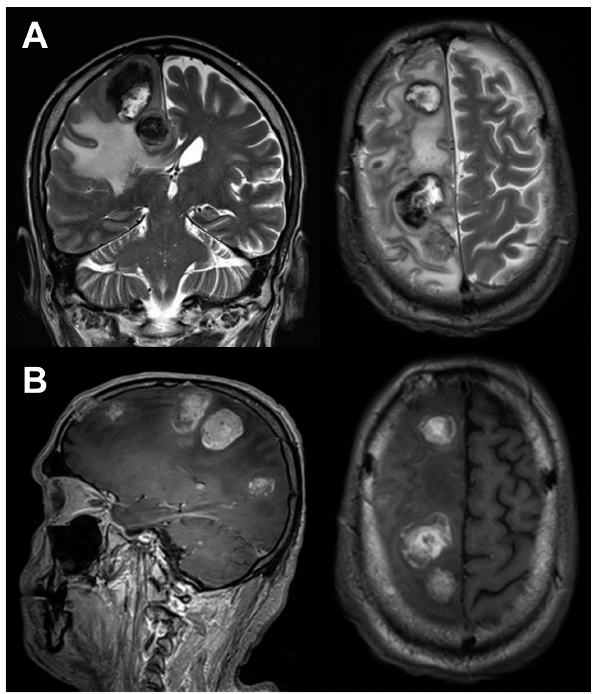
Figure 3. MRI of the brain performed subsequently to 18F-FDG-PET / CT. ( A ) Coronal and transaxial T2 images; ( B ) Sagittal and transaxial T1 TSE images. The study showed multiple metastatic lesions, widespread throughout the brain, hypointense on T2 and hyperintense on T1 images.Moreover, a large edema in the white matter of the right cerebral hemisphere and a lesion in the frontal bone infiltrating the meninx were observed. Therefore, due to extensive brain metastases [9–12] and worsening of treatment adverse effects [4], immunotherapy was discontinued and the patient was subjected to the best supportive care until his conditions progressively worsened to death after a few months.